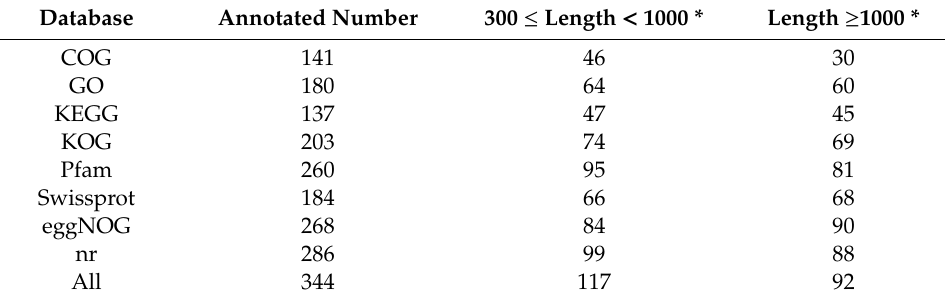
Table 5. Annotation of miRNA targets against di ff erent